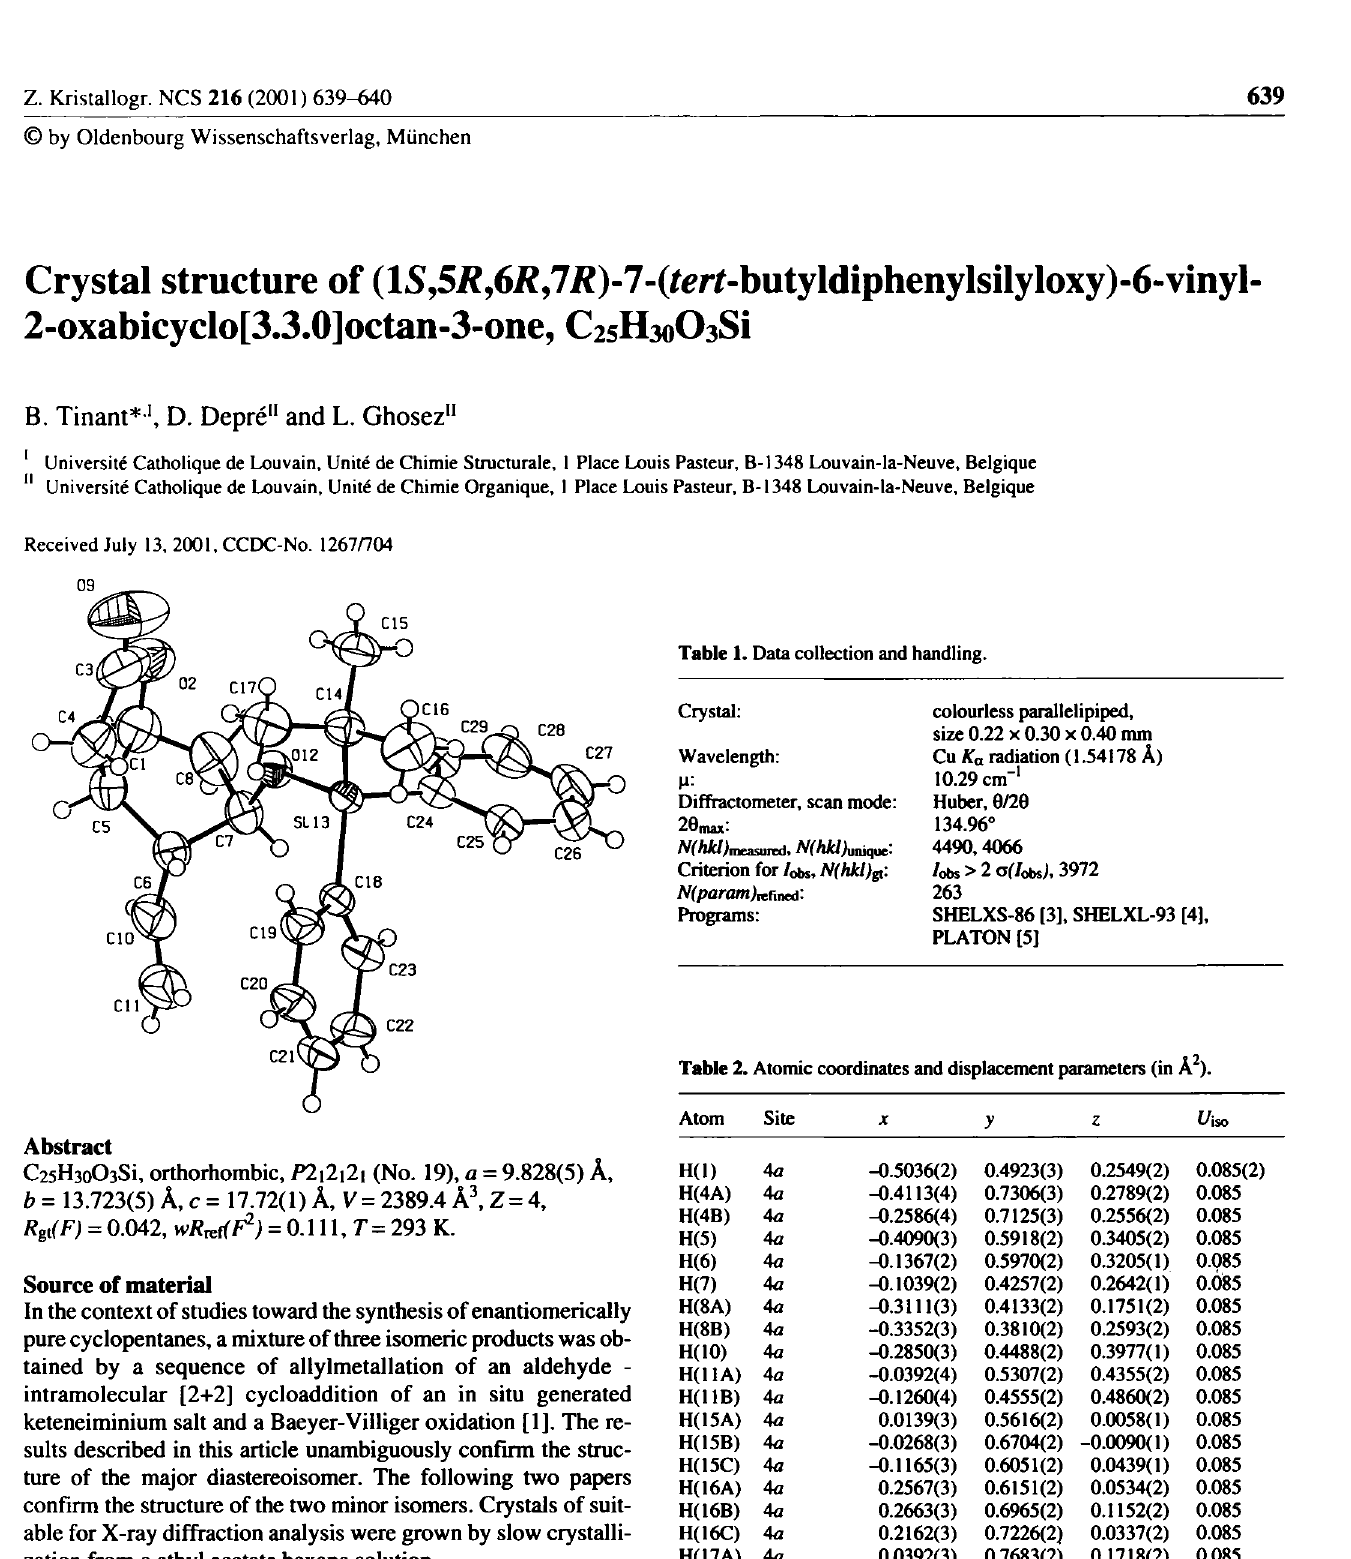
Table 2. Atomic coordinates and displacement parameters (in Ä 2